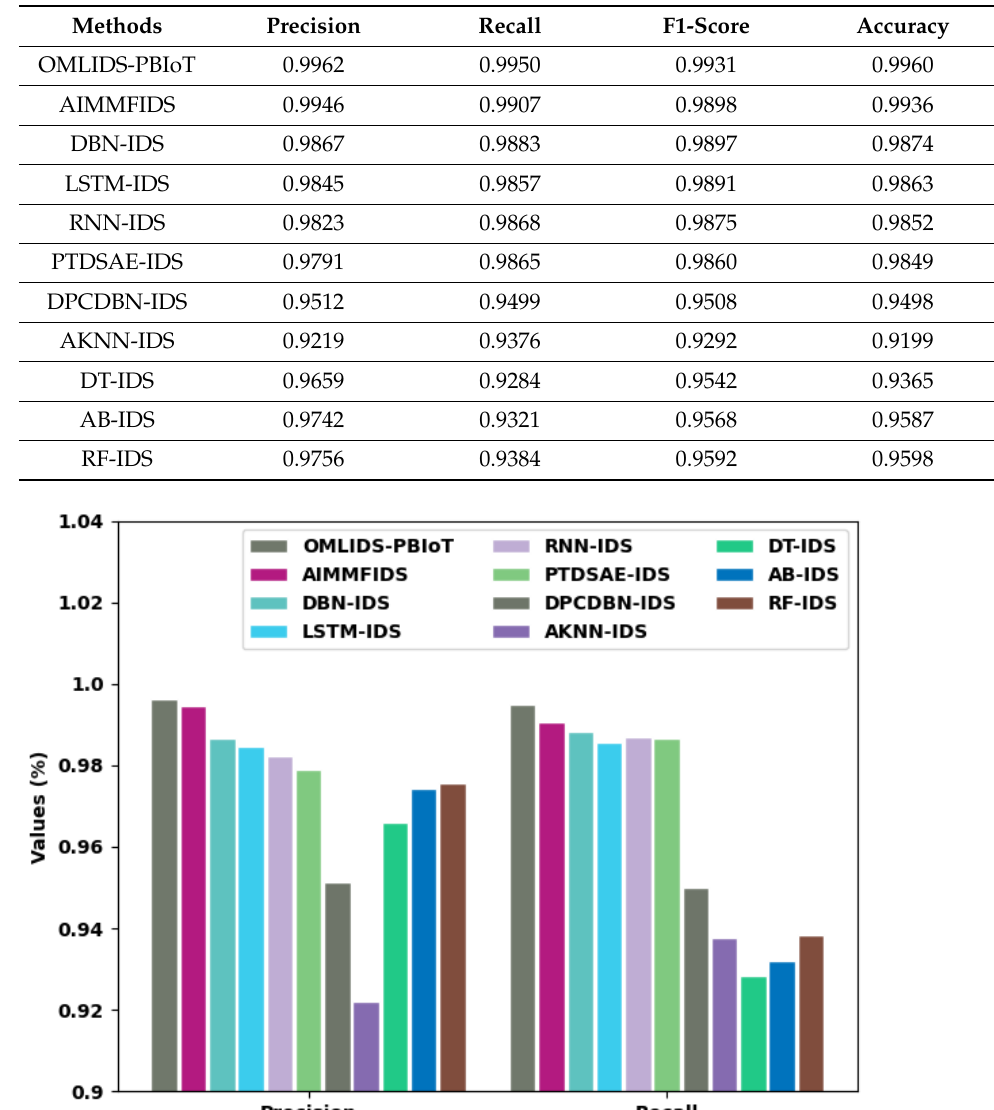
Figure 9. Prec n and reca l analysis of OMLIDS-PBIoT technique with existing Figure 9. 𝑃𝑟𝑒𝑐 𝑛 and 𝑟𝑒𝑐𝑎 𝑙 analysis of OMLIDS-PBIoT technique with existing ap- proaches.